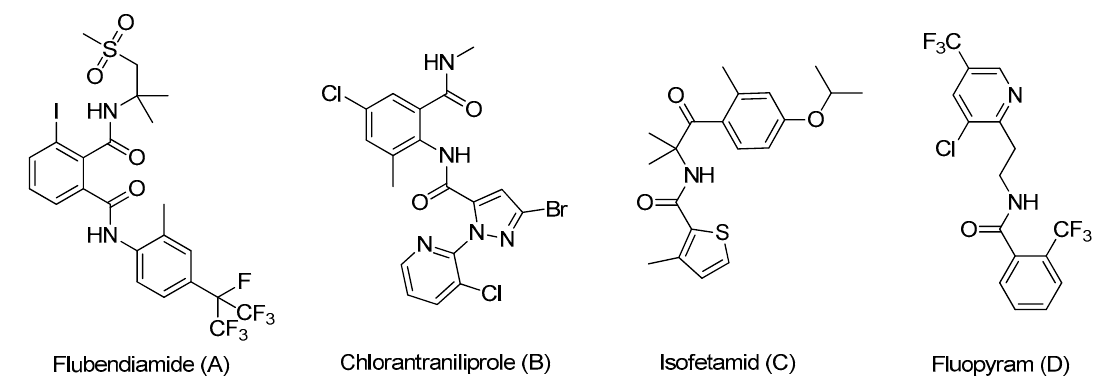
Figure 1. Structures of flubendiamide ( A ), chlorantraniliprole ( B ), isofetamid ( C ), and fluopyram ( D ).